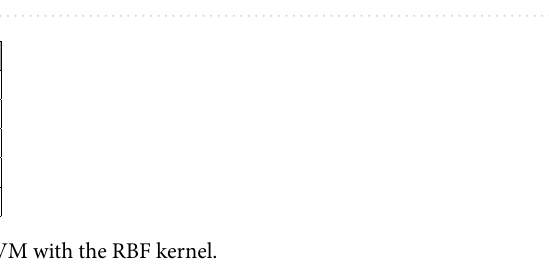
Figure 6. Plots of ROC curves for different classifier settings. (a) Comparison of five classification algorithms. (b) Comparison of gait feature vectors with different numbers of principal components.